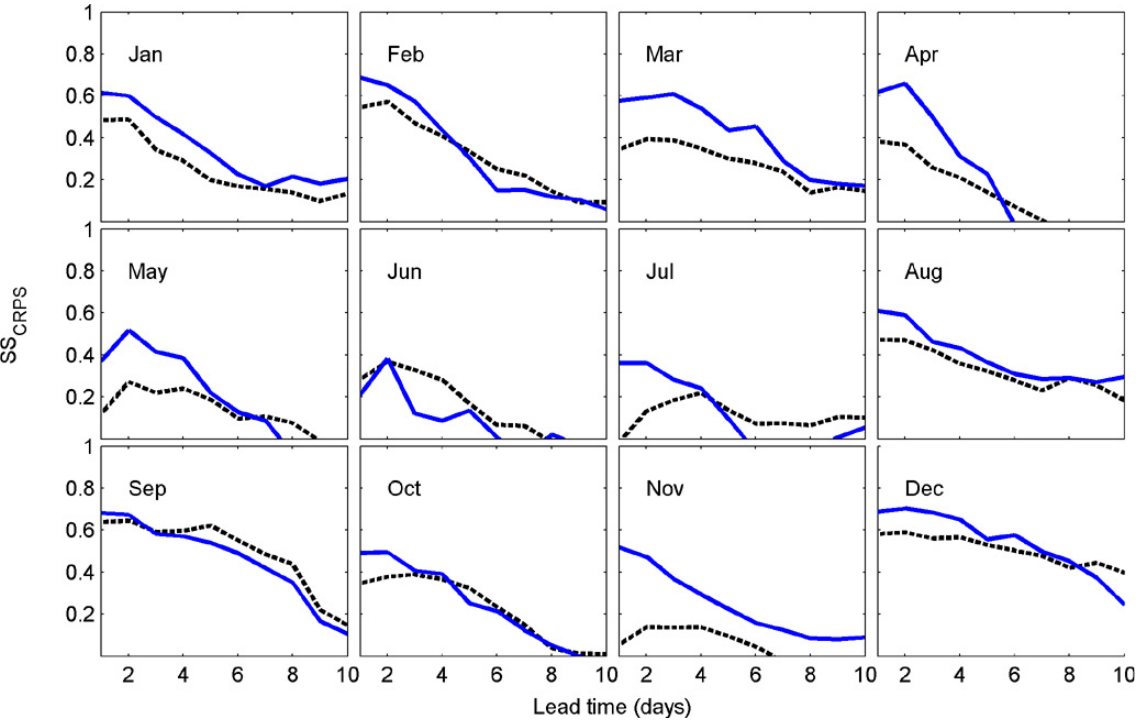
Fig. 4. Monthly S SCRPS for the HP (blue) and DP (black dotted) precipitation series compared with to the ECMWF forecast for different lead times.